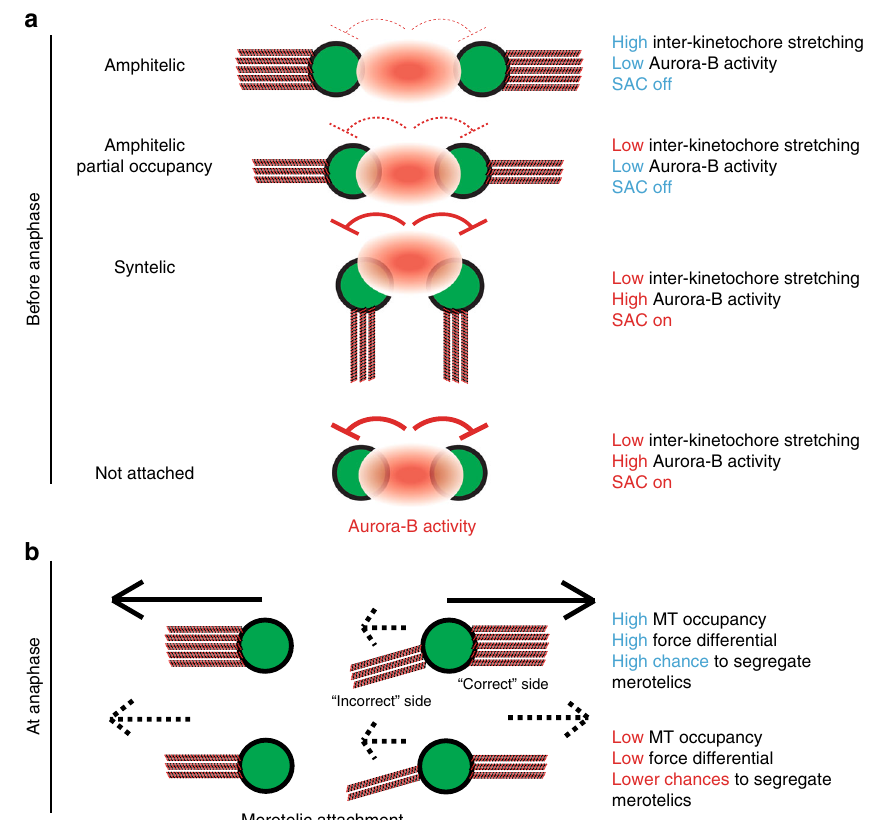
Fig. 9 Speculative model for the role of complete KT – MT occupancy. a , b Schematic model of the impact of reduced KT – MT occupancy on sister-KTs before ( a ) and after ( b ) anaphase onset. KTs are in green, Aurora-B activity gradient in red, and MTs in red-black. Full and dashed “ inhibition ” signs in red represent the respective strength of Aurora-B activity on KTs. Full and dashed black arrows represent the respective strength of the force applied by MTs on sister-KTs at anaphase. We postulate that before anaphase ( a ) complete MT occupancy and high inter-KT stretching is not required for SAC satisfaction; moreover, low inter-KT distances are not suf fi cient to induce Aurora-B-dependent MT detachment. This indicates that Aurora-B must recognize additional features in syntelic KT pairs. After anaphase onset ( b ), complete MT occupancy favours the segregation of merotelic chromosomes by increasing the likelihood of a high force differential between the “ correct ” and “ incorrect side of the lagging